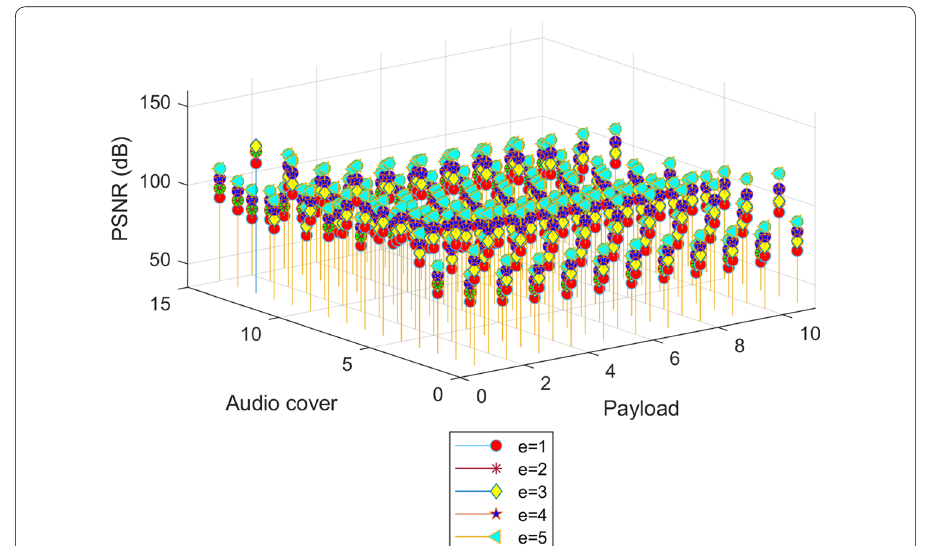
Fig. 8 The quality of the stego file generated by the proposed technique by using various smoothing coefficients, where e ∈ { 1,2,3,4,5 } , m = 1 and h =